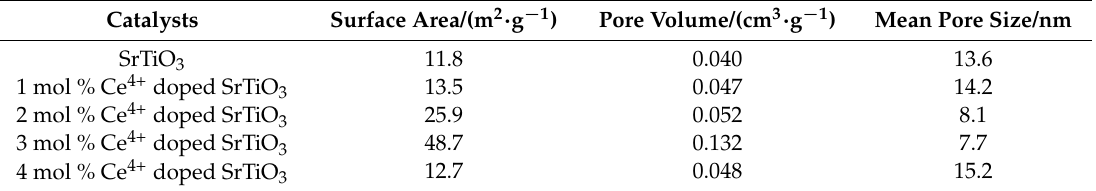
Table 3. Specific surface area, pore volume, and average pore diameter of the